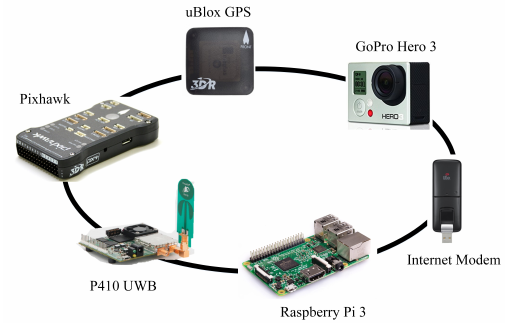
Figure 1. Sensors onboard the developed UAV platform.